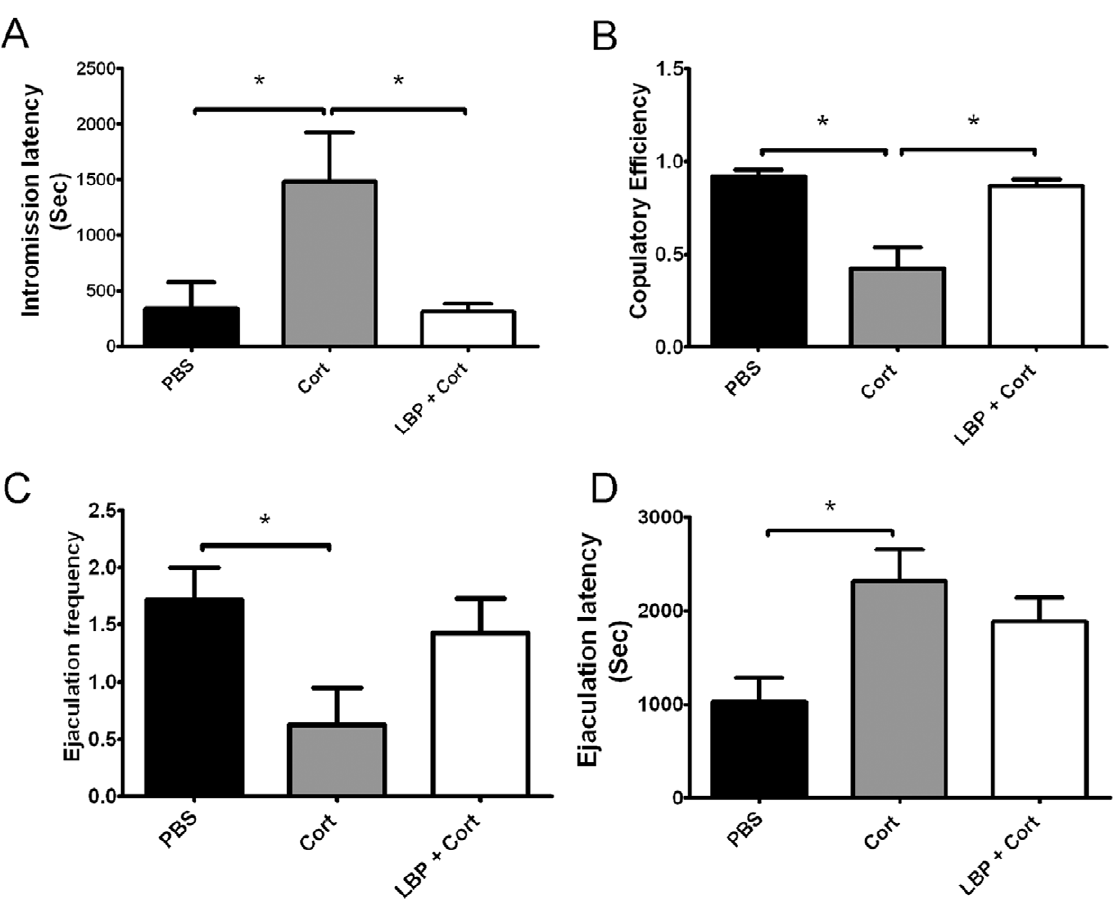
Figure 3. Corticosterone treatment inhibited sexual behavior, which is prevented by LBP treatment. (A): Intromission Latency; (B): Copulatory Efficiency; (C): Ejaculation Frequency; (D): Ejaculation Latency. Data are presented as mean 6 SEM. *: p , 0.05, ANOVA with LSD post-hoc test.